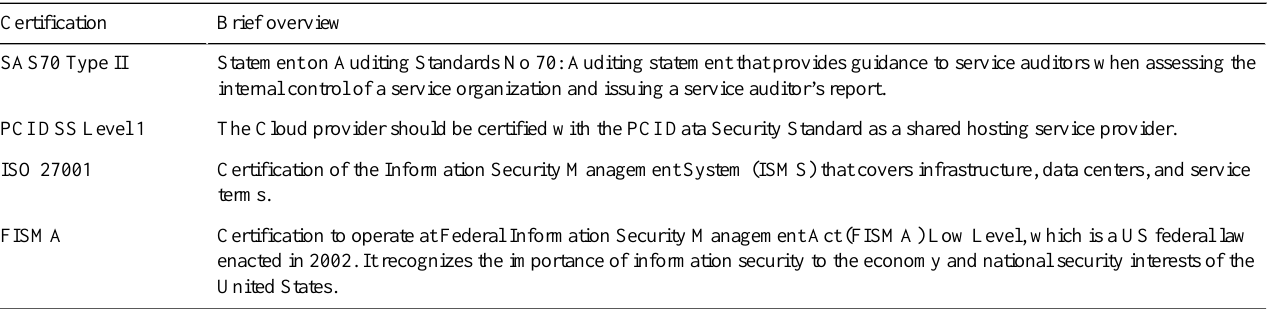
Table 3. Third-party certifications of the Cloud provider. Brief overviewCertification